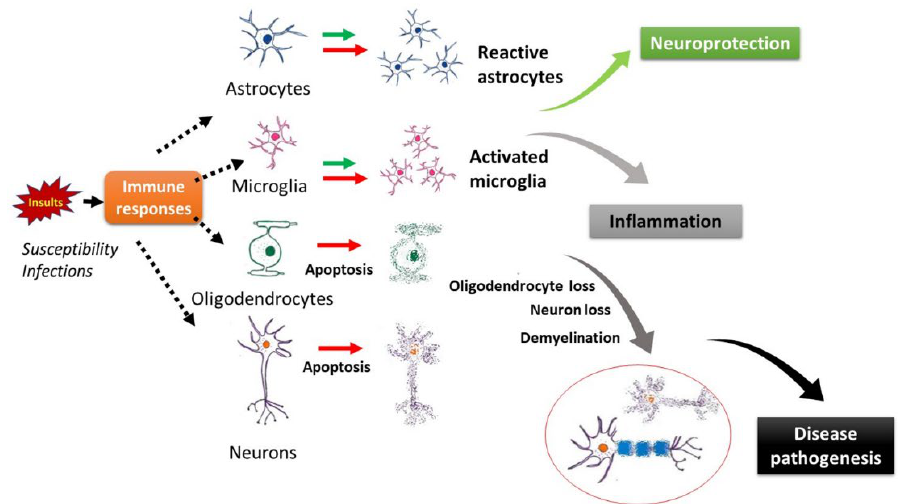
Figure 2. Schematic representation of the pathological process in MS. Infections in genetically susceptible individuals trigger responses in CNS cells, resulting in activation of astrocytes/microglia and apoptosis in oligodendrocytes/neurons. The activated glia can be protective or detrimental, which produce anti/proinflammatory cytokines in the CNS. The damaged oligodendrocytes and neurons result in demyelination and neurodegeneration, contributing to disease pathogenesis.